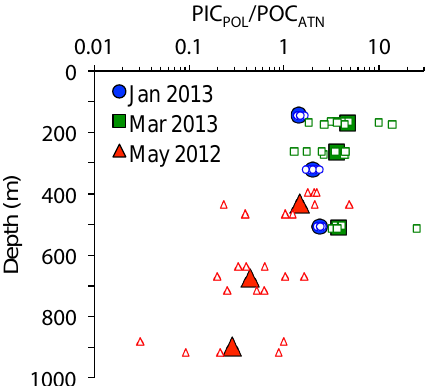
Figure 7. Depth profiles of the ratio of PIC and POC flux proxies. Results show that highest relative contribution of PIC occurred in March 2013. January and May values near 500m are